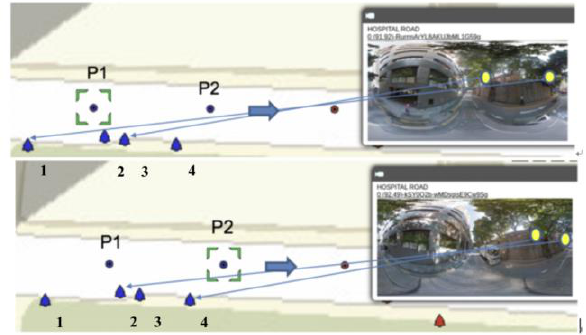
Figure 6. Duplicated tree detected for two street view images P1 and P2 are the panorama points. The arrow shows the direction of driving